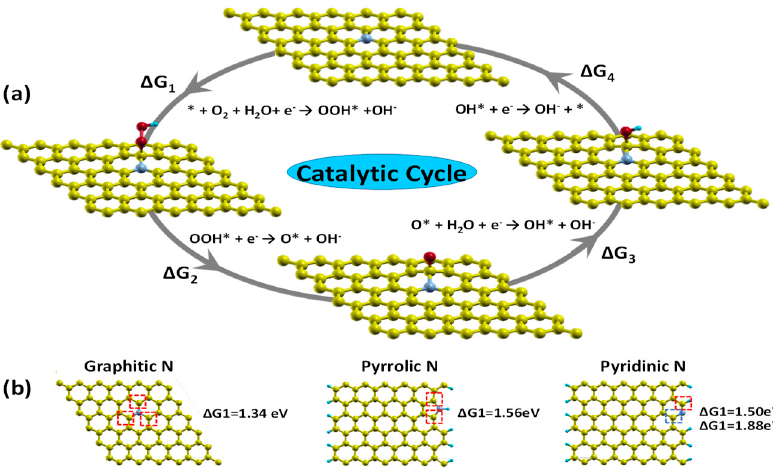
Figure 13. ( a ) Schematically showing the 4e - reduction process of ORR proceeded on N-doped carbon. ( b ) The corresponding ∆ G 1 values of the first-electron reduction process proceeded on carbon atoms surrounding different nitrogen doping configurations.